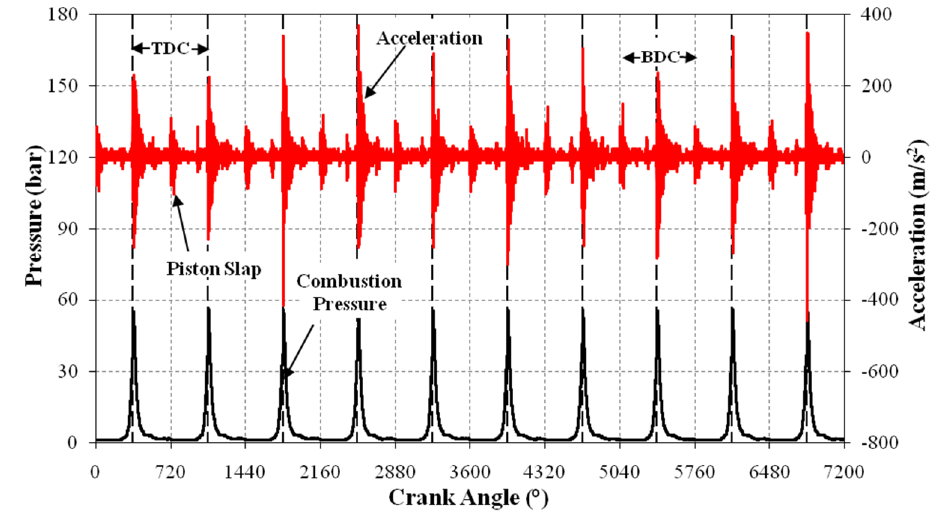
Figure 5. Vibration acceleration wave form and combustion pressure as a function of crank angle for 10 consecutive combustion cycles (diesel fuel).